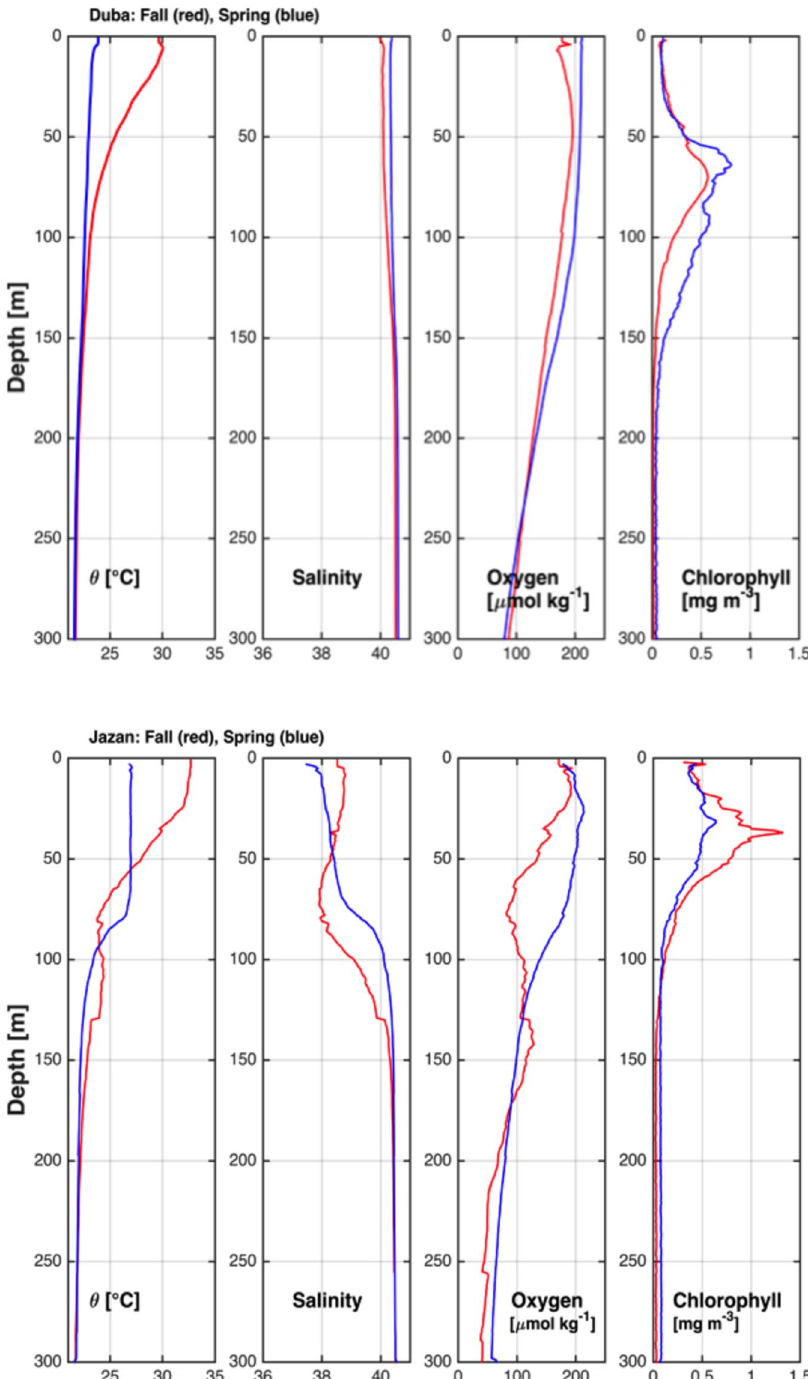
Figure 1. Mean vertical profiles of the hydrographic properties in the northern Red Sea (above) and the southern Red Sea